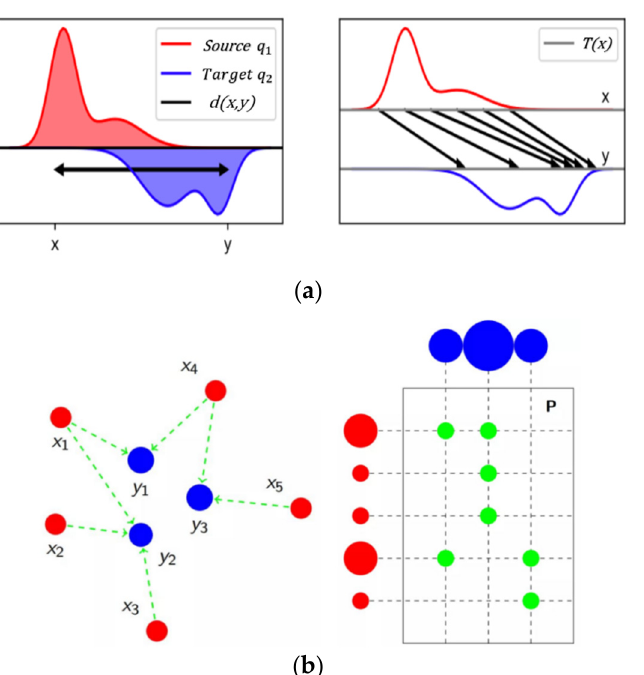
Figure 2. Optimal transport problems: ( a ) one-dimensional case; ( b ) two-dimensional case.